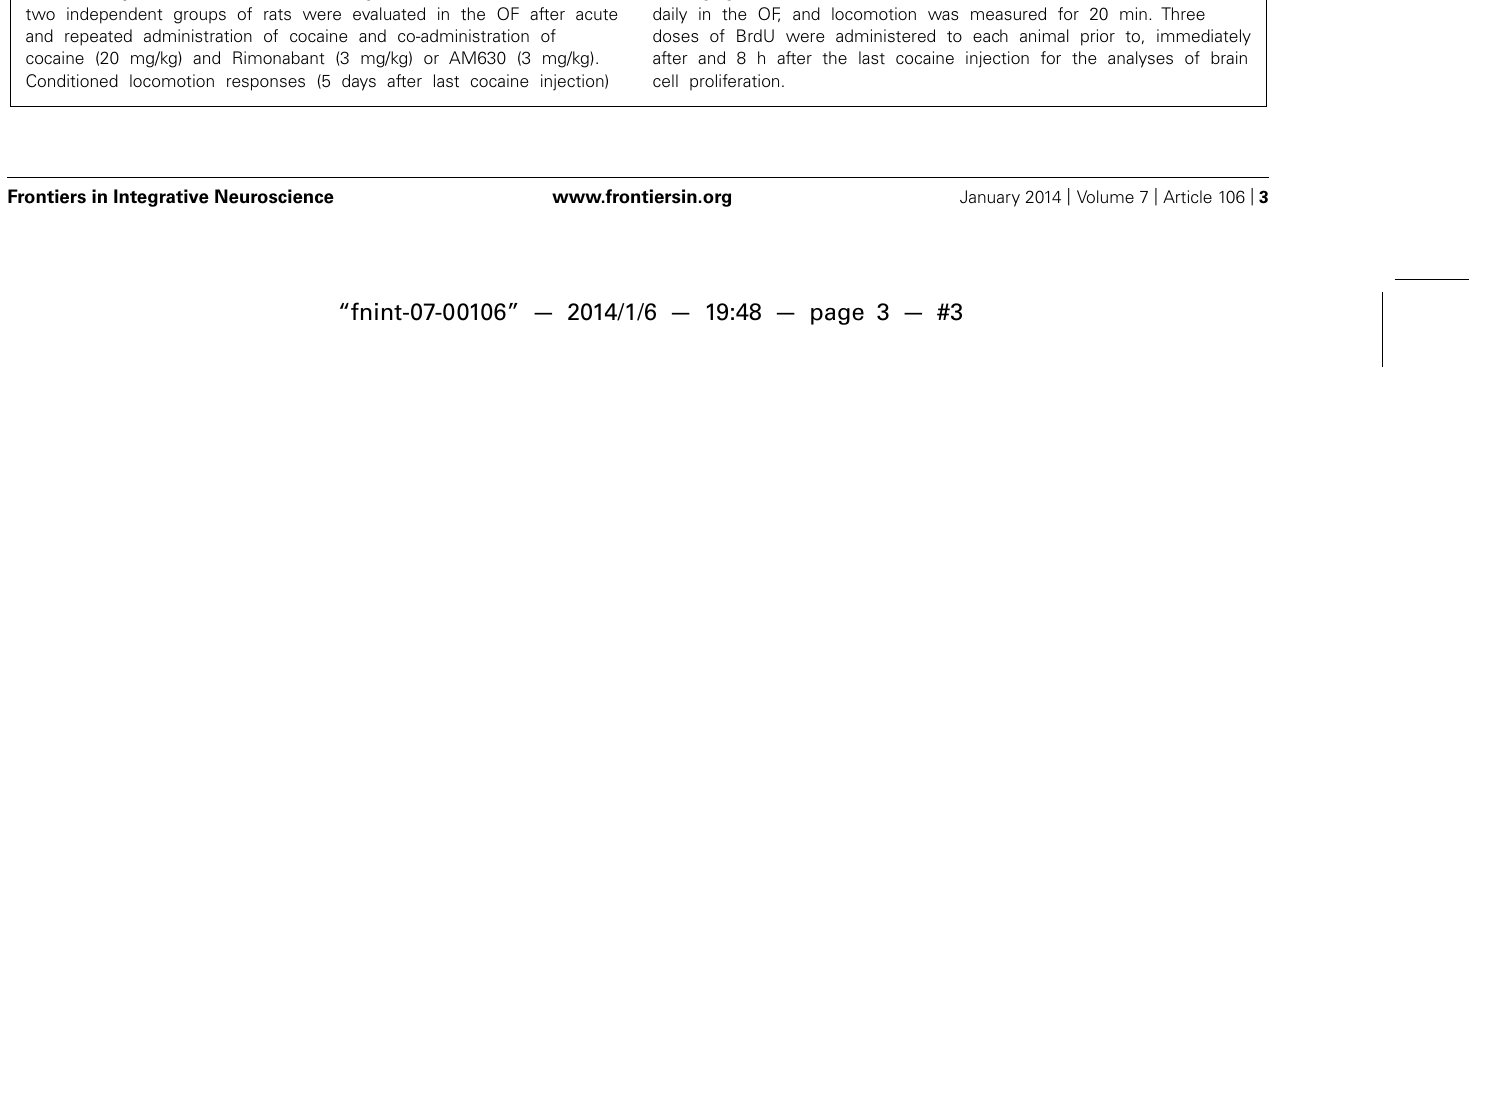
FIGURE 1 | Schematic representation of the treatments and the behavioral protocols used in this study. The locomotor activities of two independent groups of rats were evaluated in the OF after acute and repeated administration of cocaine and co-administration of cocaine (20 mg/kg) and Rimonabant (3 mg/kg) or AM630 (3 mg/kg). Conditioned locomotion responses (5 days after last cocaine injection)